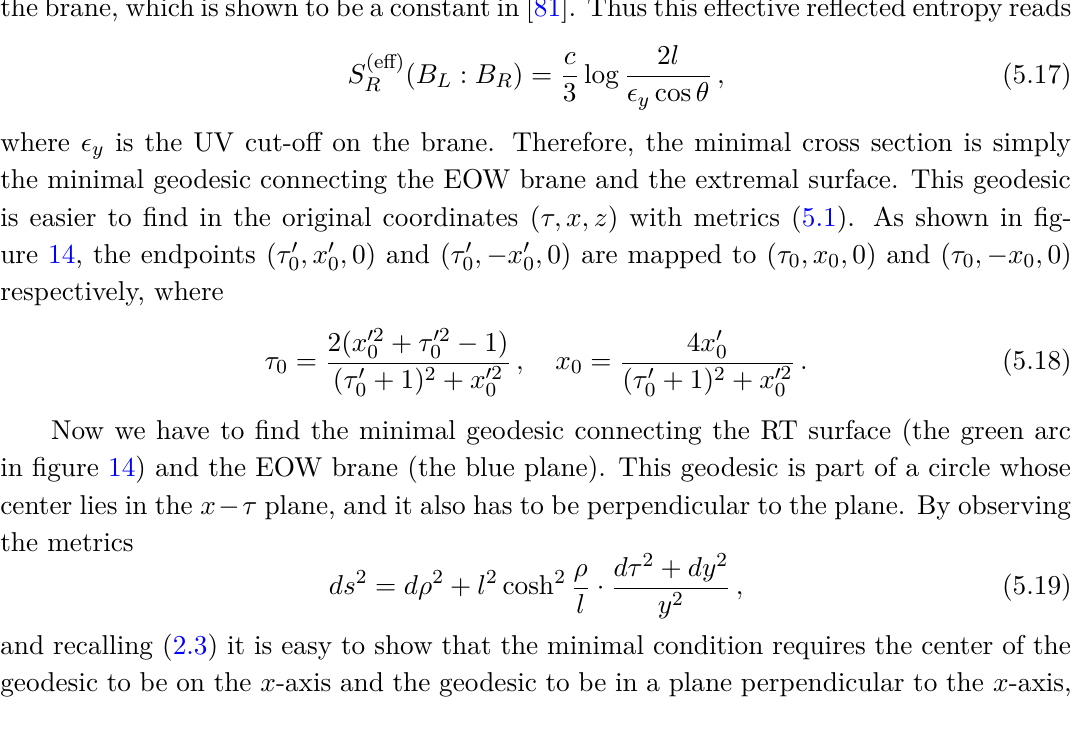
, π , π . We pick (cid:15) y = 0 . 1 and l = 1 6 4 3